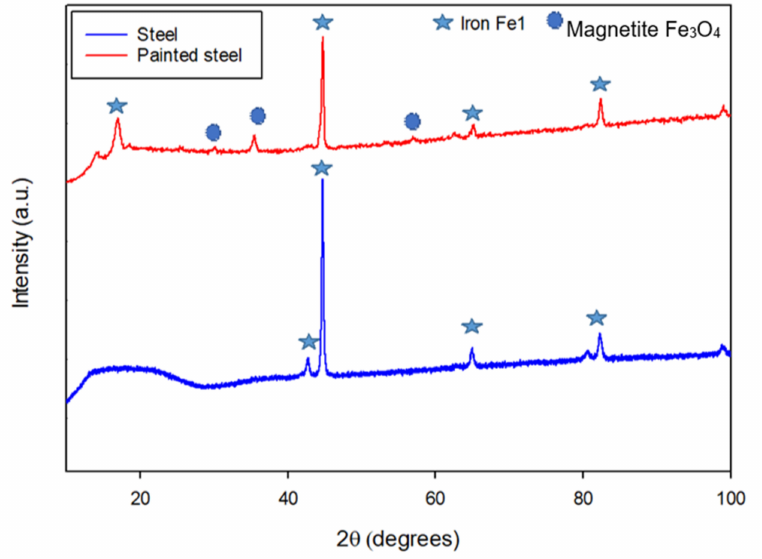
Figure 5. XRD pattern for the steel surface before immersion.